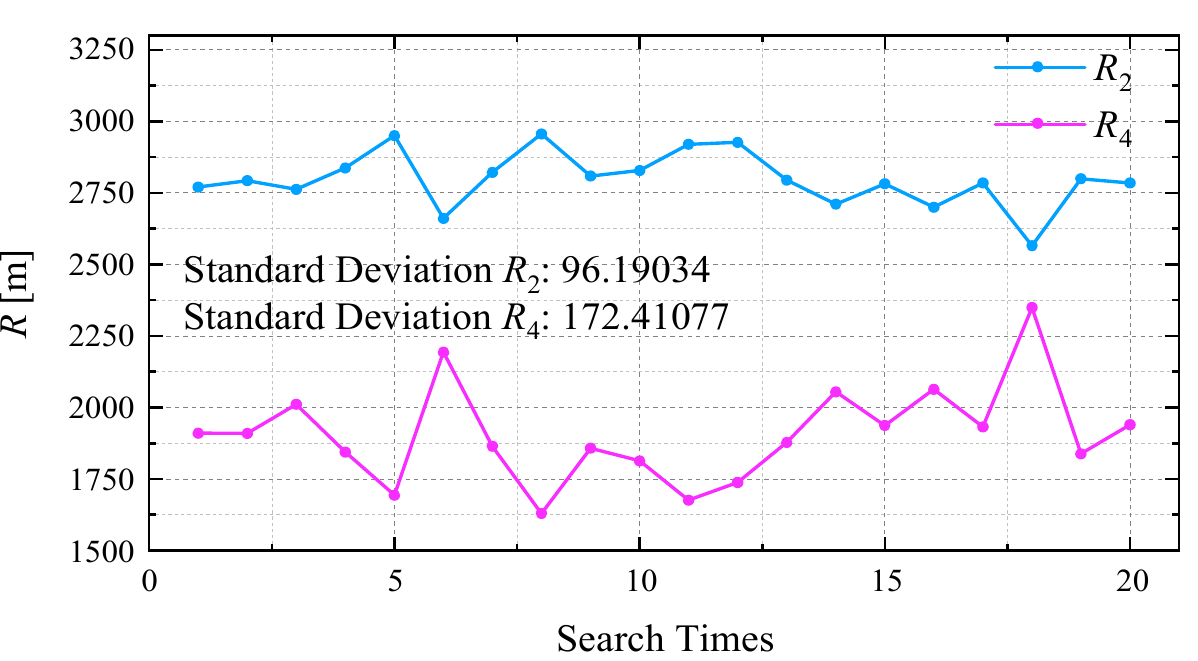
Figure 11. The fluctuations of R 2 and R 4 for 20 calculations.